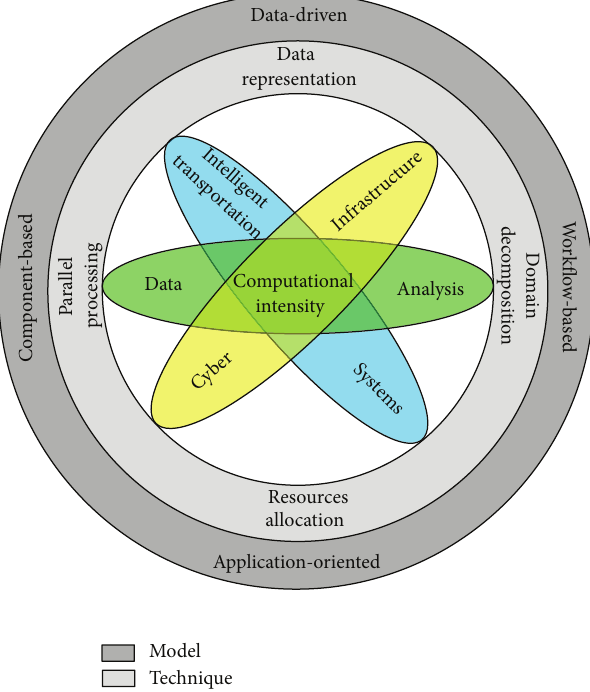
Figure 1: The Cyber-ITS framework synthesizes CI and data analysis in the context of